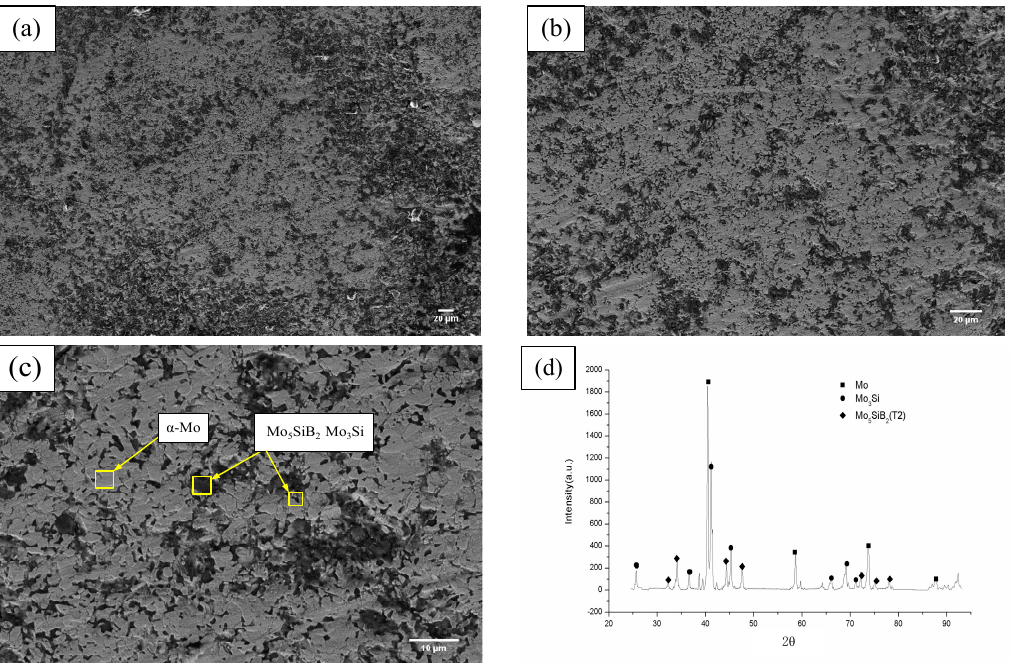
Figure 3. Microstructure of Mo–3Si–1B–1Zr–1Y 2 O 3 alloy produced by vibrating sintering ( a ) 500×, SEM; ( b ) 1000×, SEM; ( c ) 3000×, SEM; ( d ) X-ray diffraction pattern of Mo–3Si–1B–1Zr–1Y 2 O 3 .